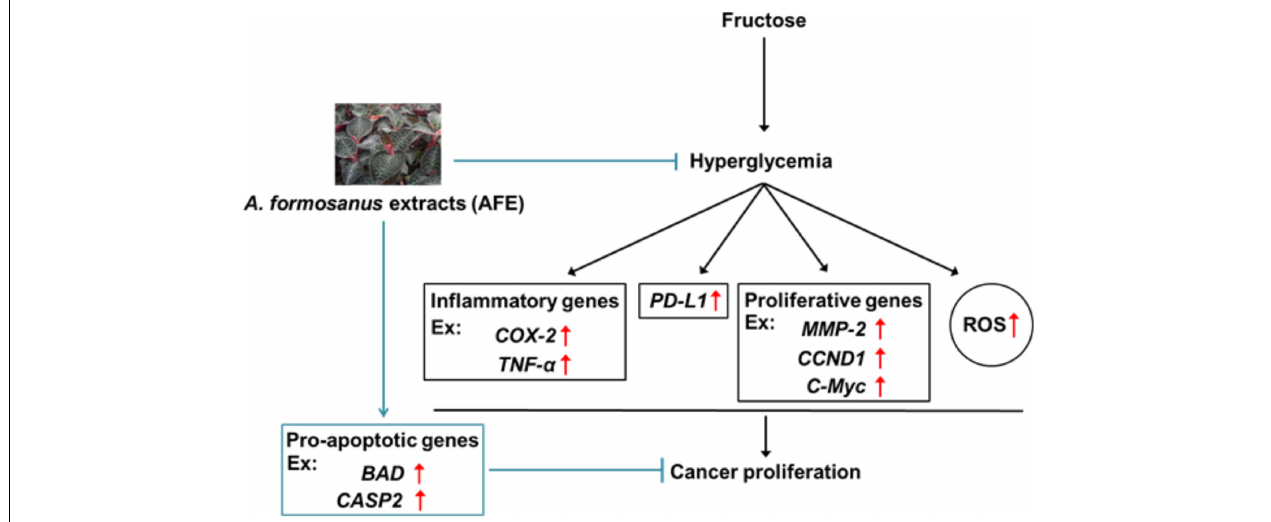
FIGURE 7 | Mechanism involved in Anoectochilus formosanus extract-induced anti-proliferation in cancer cells. Hyperglycemia modulates expression of inflammatory genes and increases ROS accumulation. A. formosanus extract can reduce ROS accumulation and inhibits PD-L1 expression and further block expression of inflammatory, proliferative, and metastatic genes. All of them are important for anti-proliferation in cancer